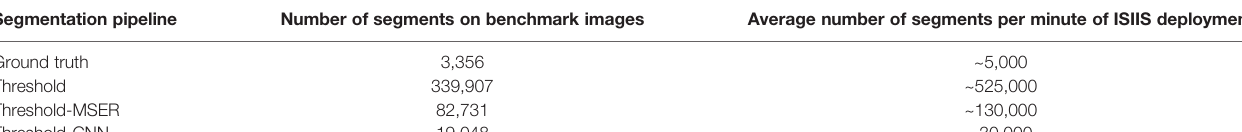
TABLE 2 | Number of segments generated by each pipeline on the 106 benchmark images and estimation of the amount of segments they would produce on one minute of ISIIS data. Segmentation